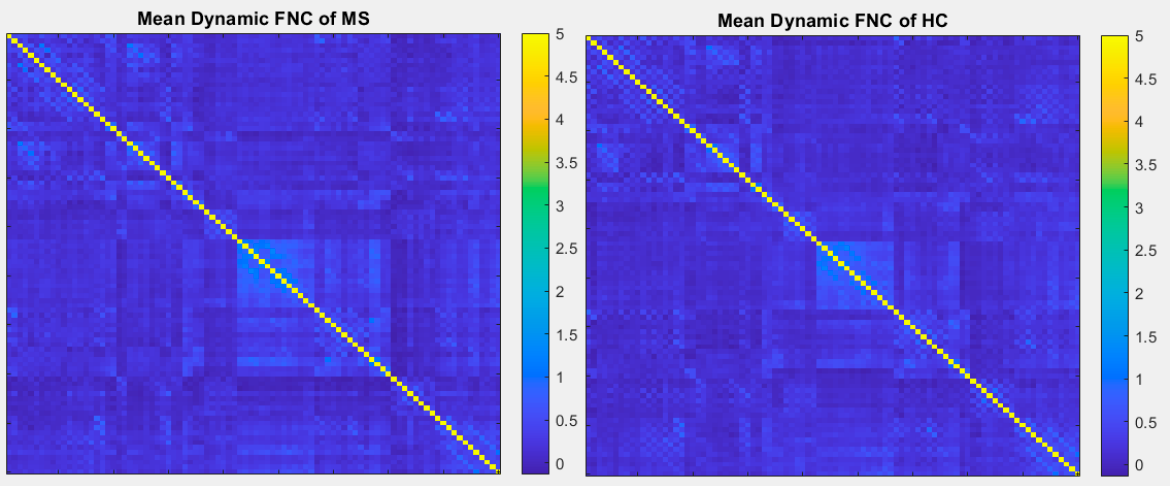
Figure 10. Mean dynamic FNC of both MS group and healthy control group using correlation with 90 brain regions defined by AAL atlas.